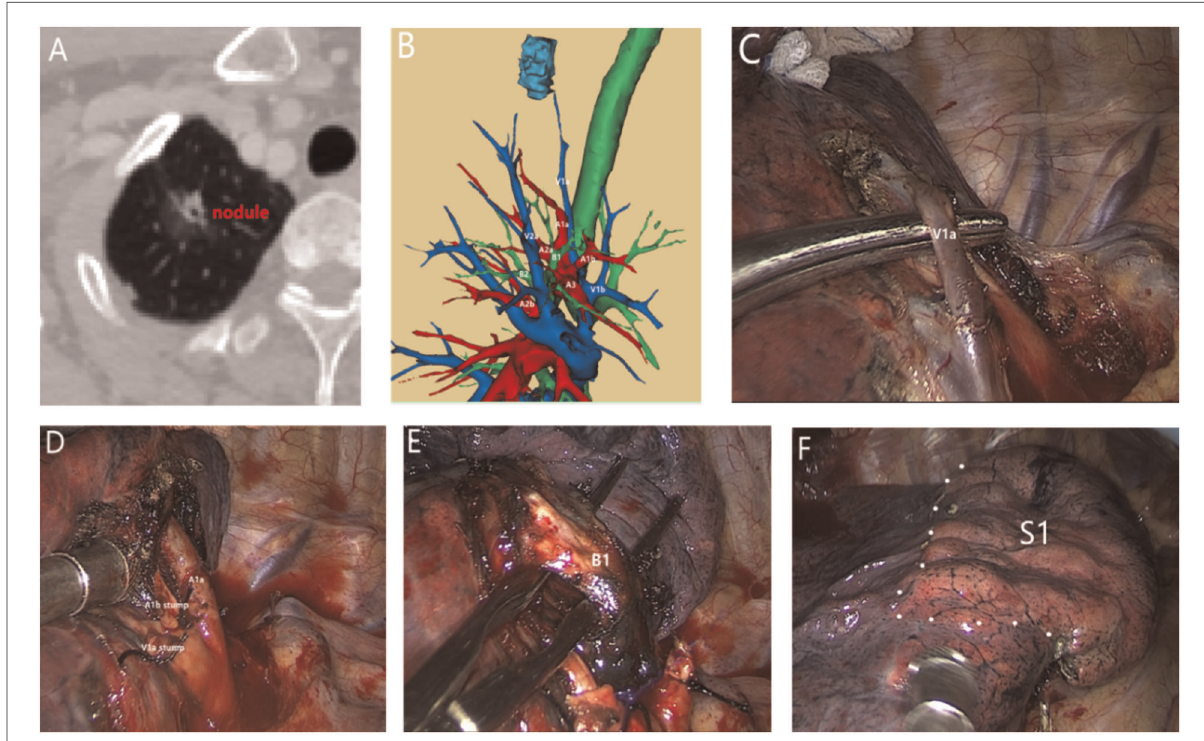
FIGURE 1 A 54-year-old male patient with nodules in the upper lobe of the right lung and a history of diabetes underwent right upper lobe apical segment resection. Postoperative pathology revealed invasive adenocarcinoma. ( A ) Preoperative computed tomography, right upper lobe apical nodules, 1.7 cm in diameter. ( B ) Preoperative 3D bronchovascular imaging of the right upper lobe apex segment. ( C ) Separation of V1a. ( D ) Separation and detachment of A1a and A1b. ( E ) Separation of B1. ( F ) S1 intersegment